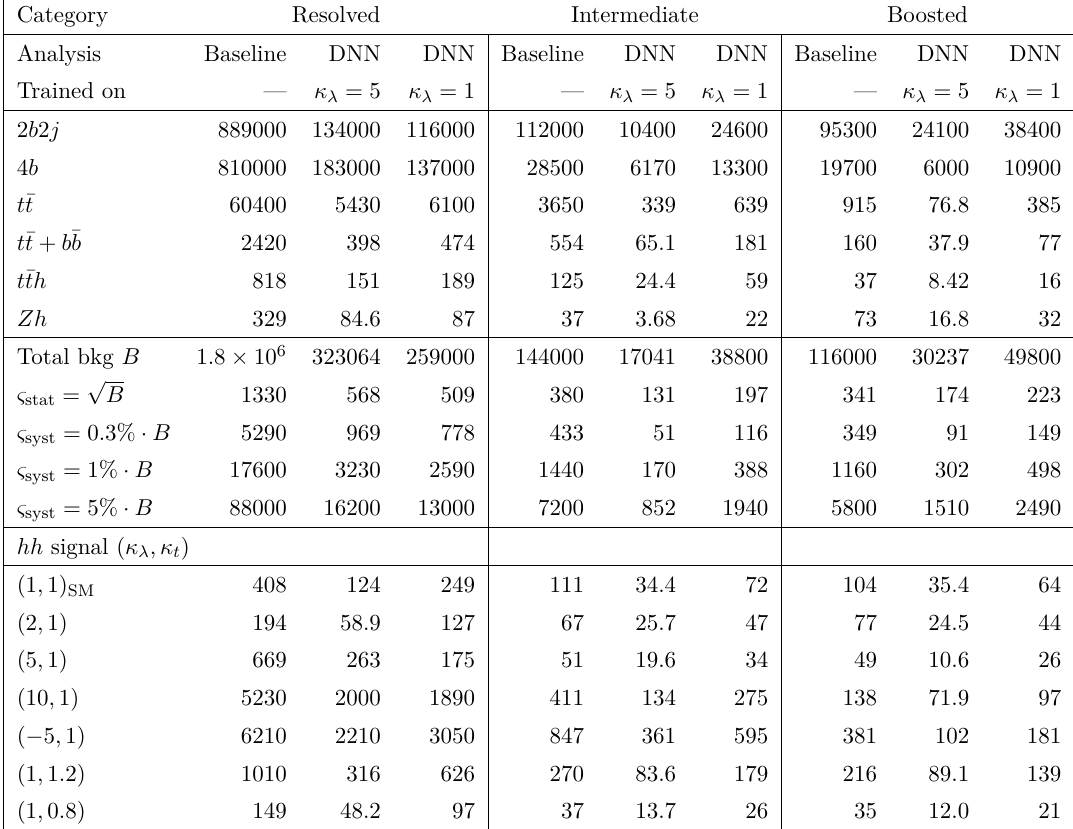
Table 4. Summary of signal region yields for the backgrounds and benchmark signals for the baseline analysis and neural network analyses (DNN) trained on κ λ = 1 and κ λ = 5 . The yields shown are prior to binning in m hh and normalised to integrated luminosity of L = 3000 fb − 1 . Dom- inant contributions to backgrounds are displayed together with the absolute size of the statistical ς stat and benchmark systematic ς syst uncertainties. Signals with benchmark couplings ( κ λ , κ t ) are shown, where (1 , 1) is the SM